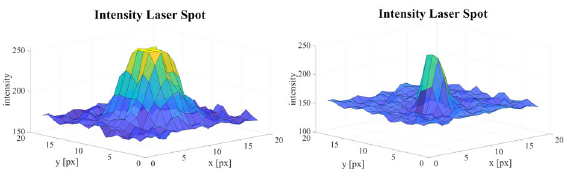
Figure 15. Intensities of a laser spot of the PCO camera; left: red colour channel, right: green colour